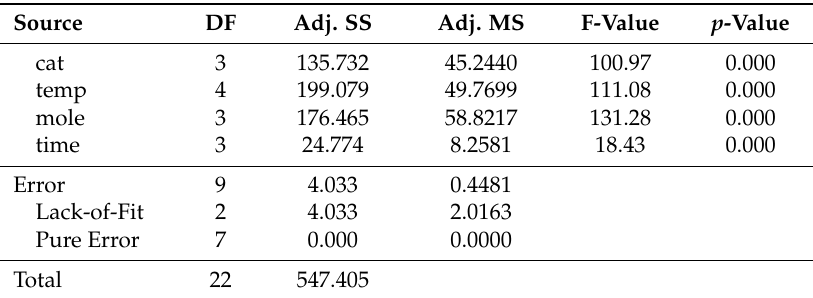
Table 5. Analysis of variance (ANOVA) for the linear model.